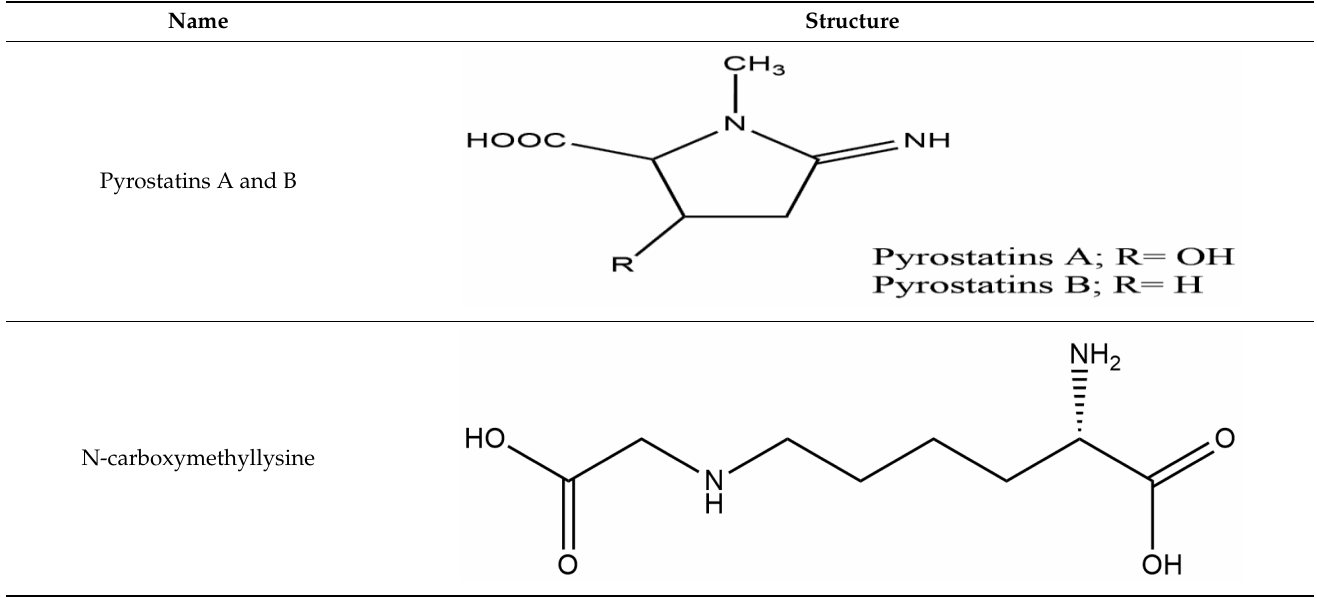
Table 2. The below table lists the marine drugs used in diabetes mellitus and their respective